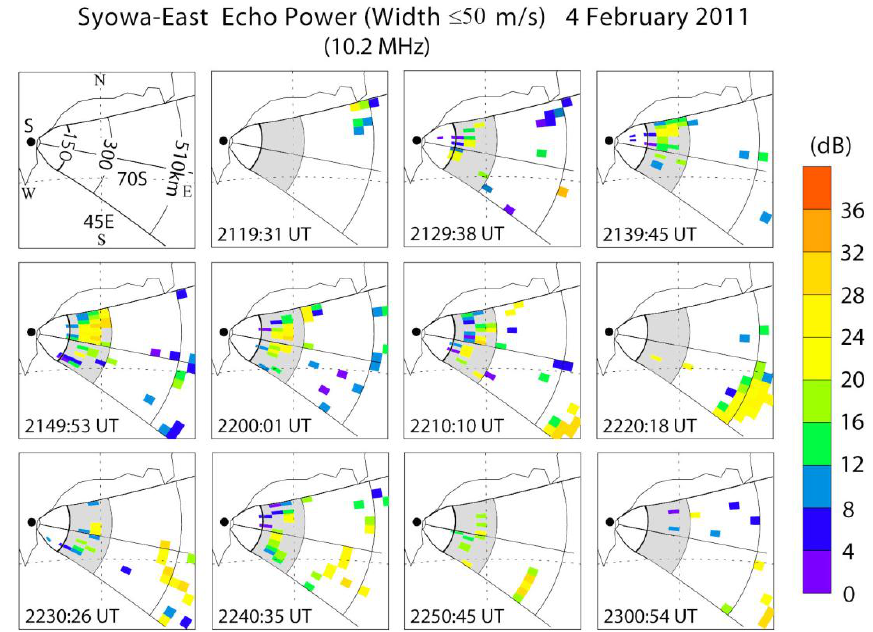
Fig. 5. Two-dimensional plots for time variation of echo power (with a spectral width smaller than 50ms − 1 ) between 21:09:25 and 23:00:54UTC. Location of Syowa Station, radar field of view, and ground ranges are indicated in the top left panel. The most sensitive regions for PMSE detection (ground range 150–300km) are displayed with a gray band.